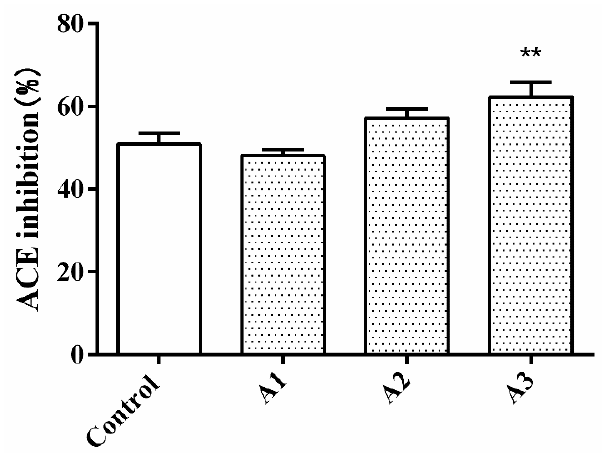
Figure 1. Angiotensin–converting enzyme (ACE) inhibitory rates of ultrafiltration fractions of glutelin-1 hydrolysates of walnut at the concentration of 1.0 mg/mL. Control: Glutelin-1 hydrolysate before separation and purification. All data are presented as the mean ± SD of triplicate results. ** p < 0.01, vs. the control, A1–A3 represent the three fractions obtained after ultrafiltration separation, A1 (MW > 5 kDa), A2 (3 < MW <5 kDa) and A3 (MW <3 kDa).